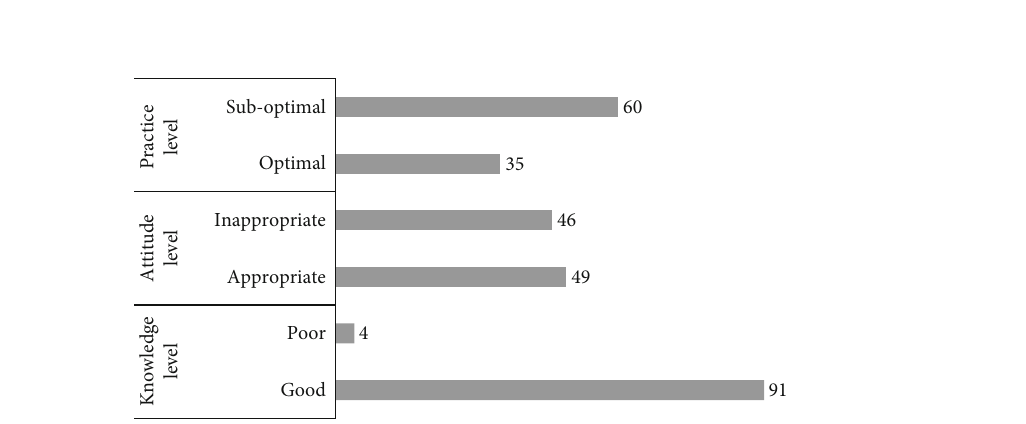
Figure 1: Number of study participants with the knowledge, attitude, and practice levels.